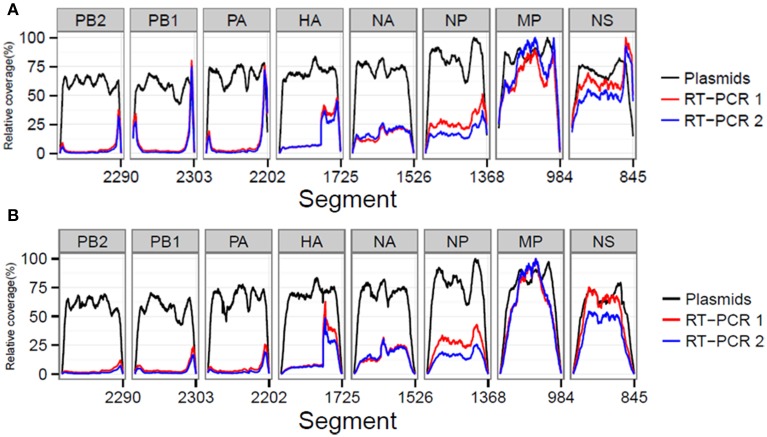
The sequencing process and quality control steps do not lead to a selective bias for particular influenza segments as comparable relative coverages for the plasmid dataset before (A) and after (B) QC were obtained. In both RT-PCR samples 1 and 2 preferential amplification of the smaller segments was observed.